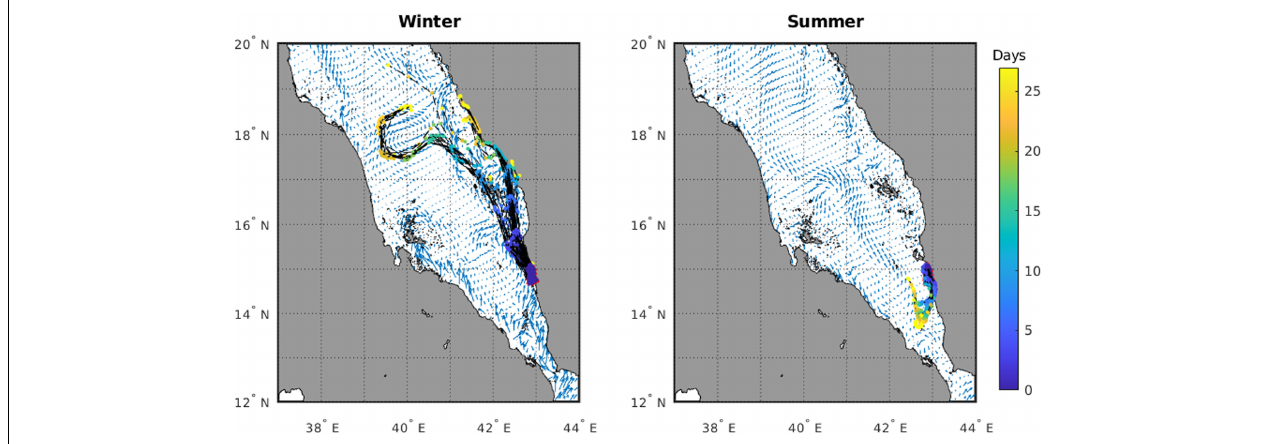
FIGURE 1 | Modeled trajectories of 100 particles released off the coast of Yemen and advected passively for 30 days (time from releasing is color coded) using the climatological monthly mean surface currents for February (left panel) and August (right panel) (Biton et al., 2010). The surface velocity fields (blue arrows) are also shown.